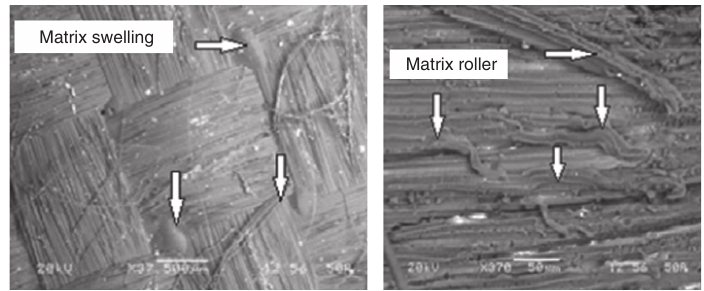
Figure 4 SEM micrograph of LN